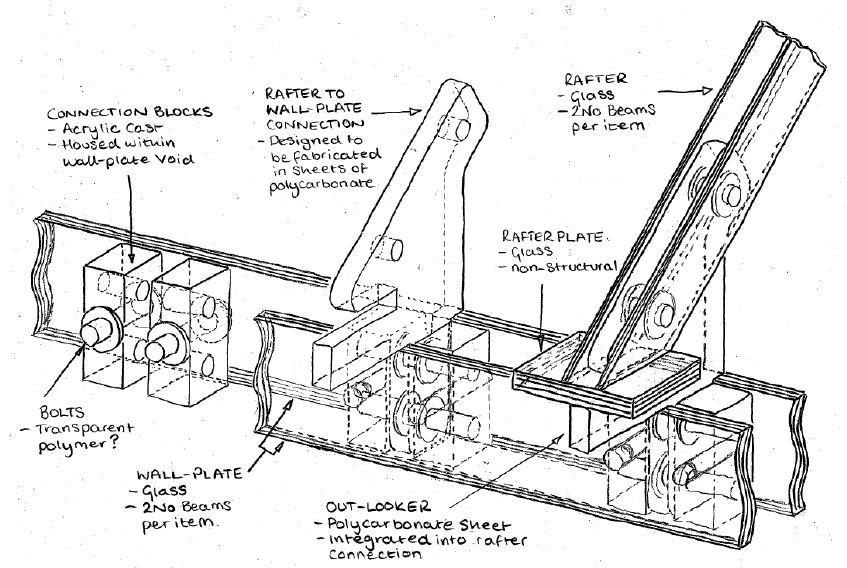
Figure 4: Alternative connection details utilizing polycarbonate